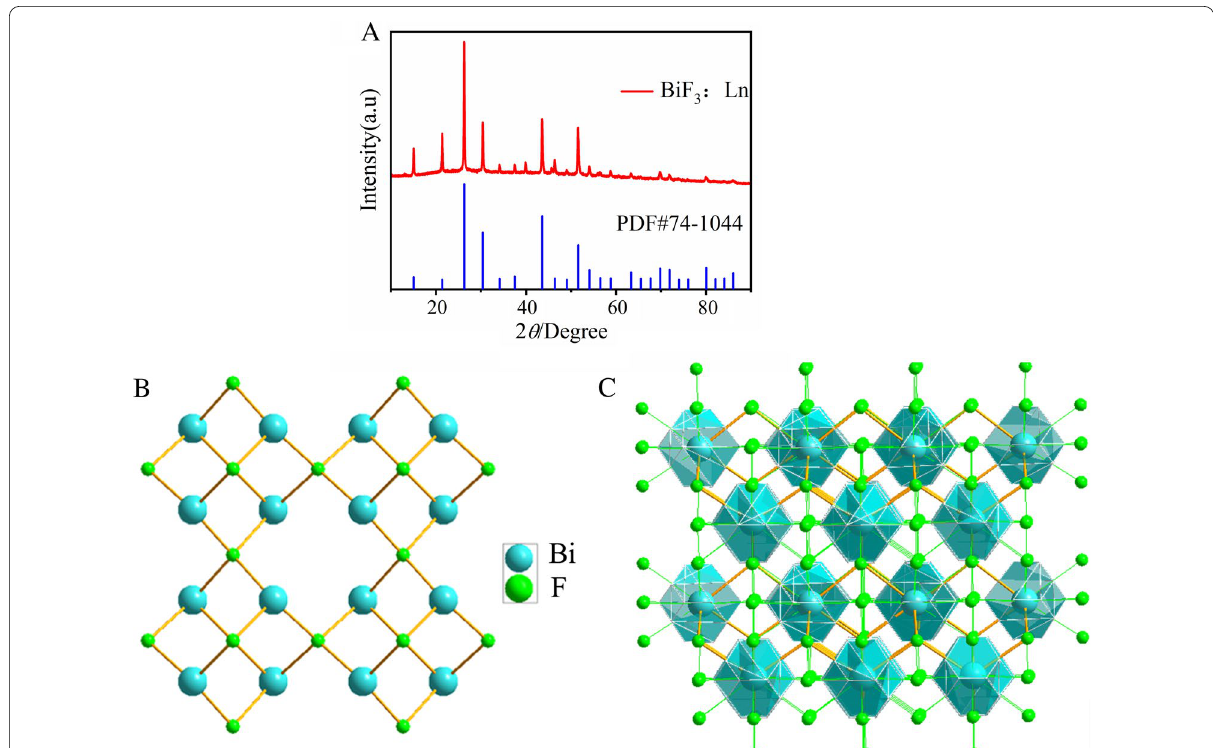
Fig. 3 XRD pattern of BiF 3 : Ln@PVP NPs. A All peaks of the BiF 3 : Ln are well-matched with standard card BiF 3 : Ln data (PDF 74-0144). B The view of atomic distribution from C axis and C show the coordination along the A